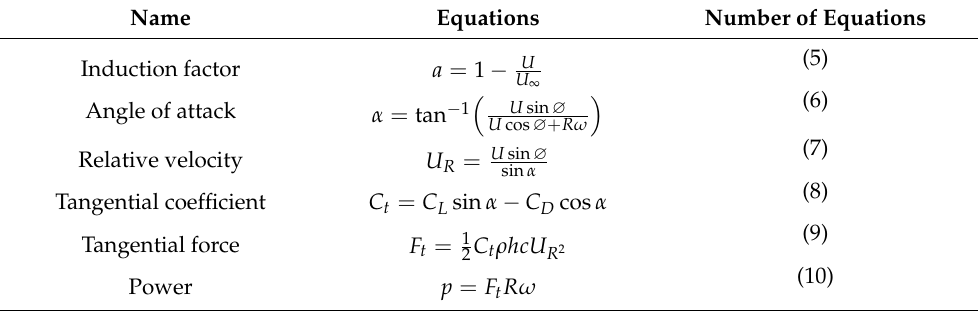
Table 3. Equations used in the flowchart (Figure